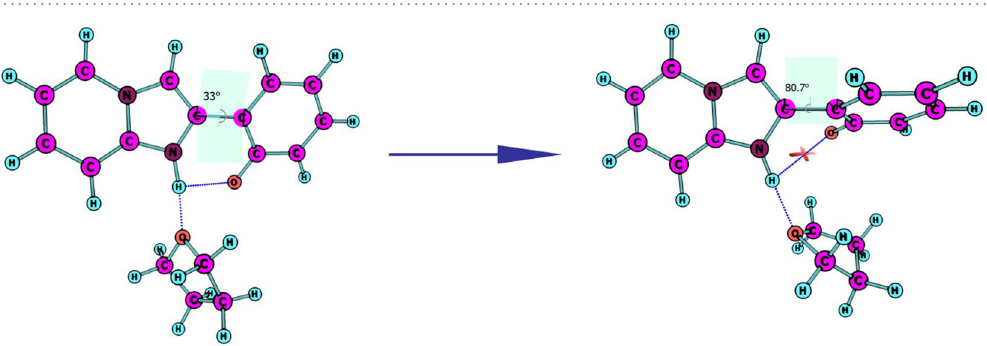
Figure 6. ( a ) the interaction between THF molecule and ik-HPIP leads to ( b ) the formation of v-HPIP in the S 1 state.